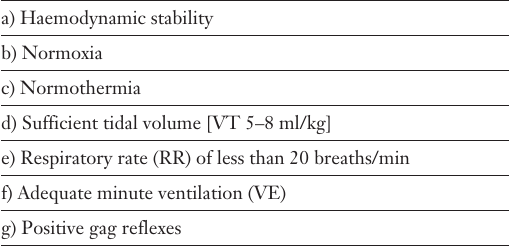
diate extubation after OLT